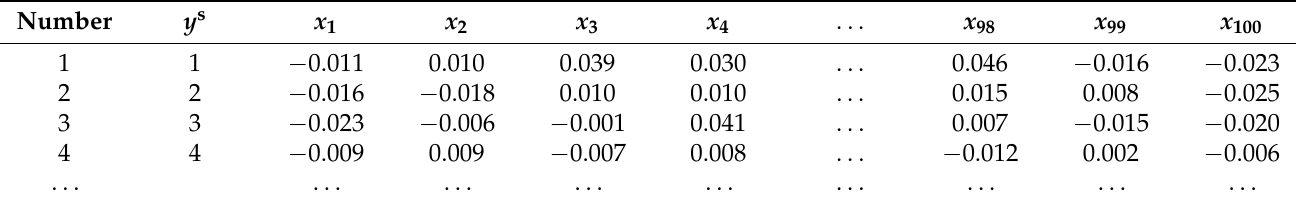
Table 5. Independent variable data set integrating fault phenomenon and fault location